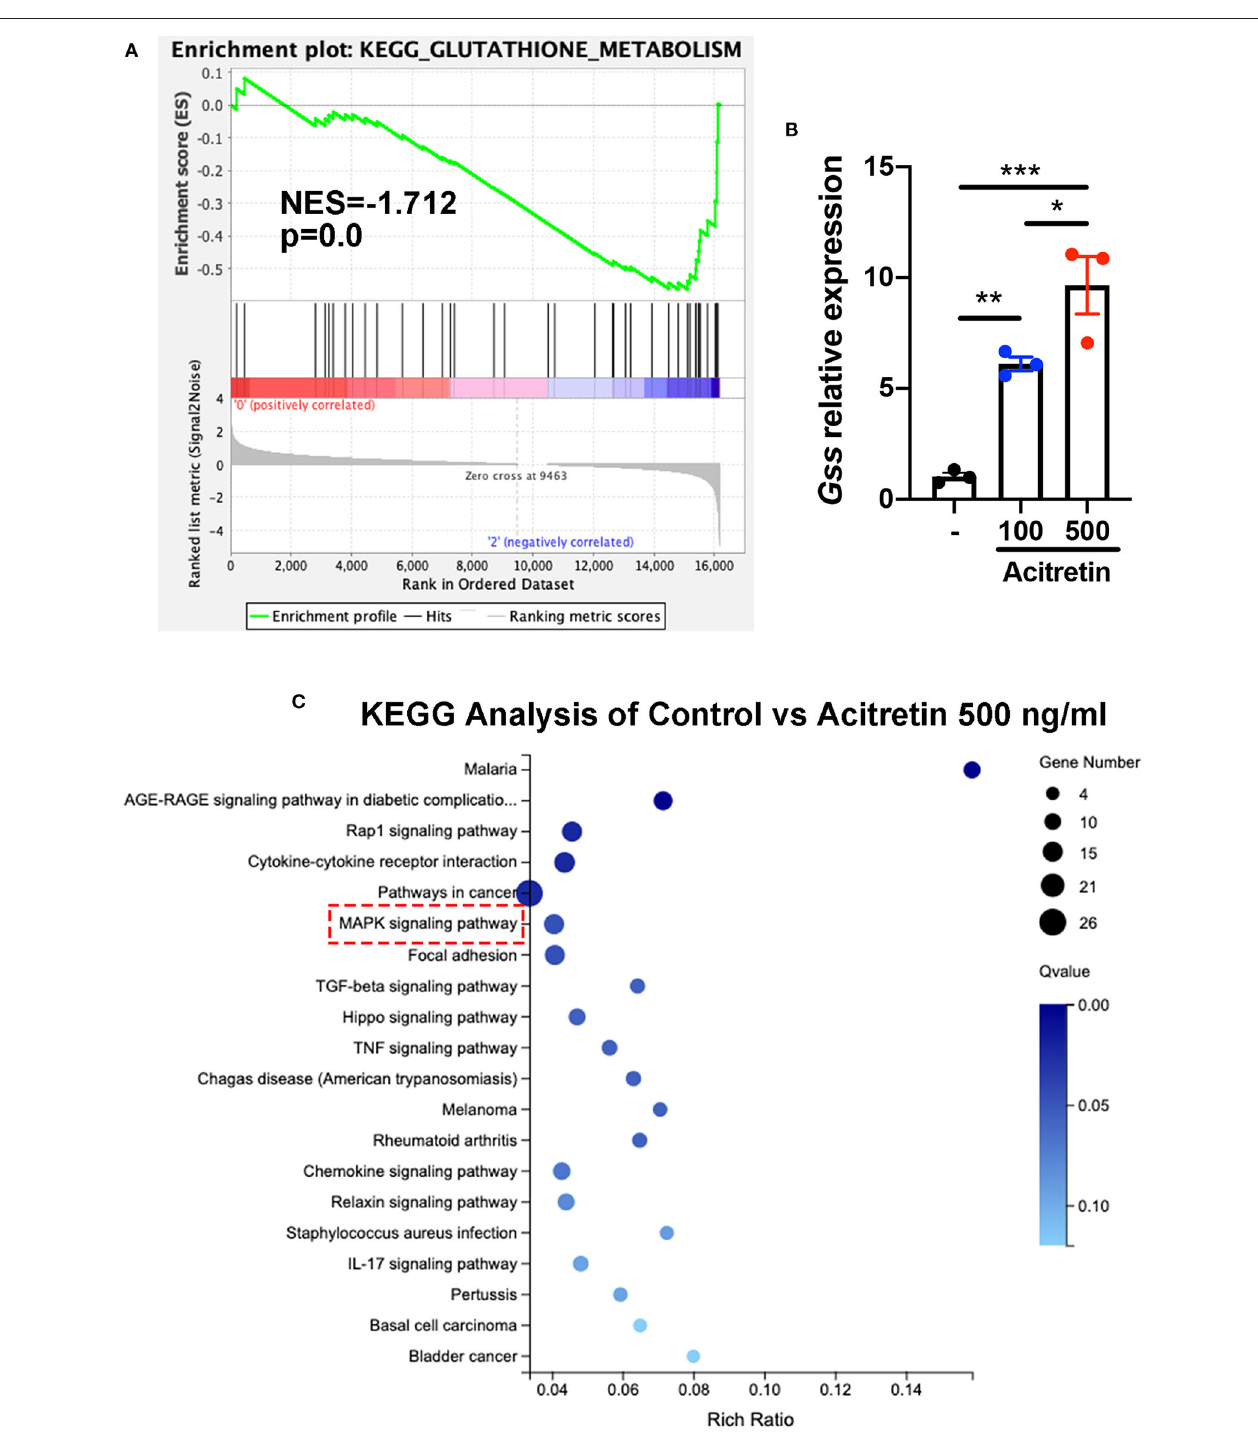
FIGURE 4 | Transcriptome analysis of MDSCs treated with acitretin. MDSCs were isolated from the bone marrow of IMQ-induced model mice and cultured in the presence of 20ng/mL GM-CSF with or without acitretin 500ng/mL. After 24h of treatment, MDSCs were collected and used for whole-genome transcriptome analysis. (A) Glutathione metabolism enriched by GSEA identified from RNA-seq data of control vs. acitretin group. Normalized enrichment score (NES) and Normalized p -value (p) are shown in the plot. (B) MDSCs were treated with control (-), acitretin 100ng/mL, or acitretin 500ng/mL for 48h. Expression levels of Gss were examined by RT-qPCR. The results are representative of at least three independent experiments with three samples per group in each. Data represent the mean ± SEM. * p < 0.05, ** p < 0.01, *** p < 0.001. (C) KEGG pathways analysis of differentially expressed genes in MDSCs treated with control or acitretin 500ng/mL for